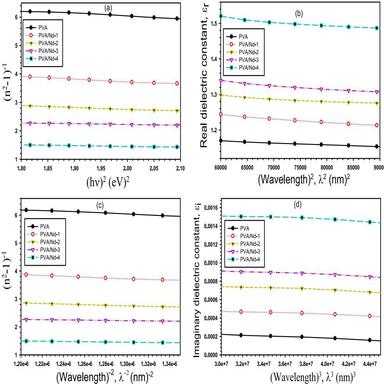
(a) (n2 -1)− 1 with (hυ) 2 , (b) εr with λ2 , (c) (n2 -1)− 1 with λ− 2 , and (d) εl with λ3 for PVA and PVA/Nd2O3.